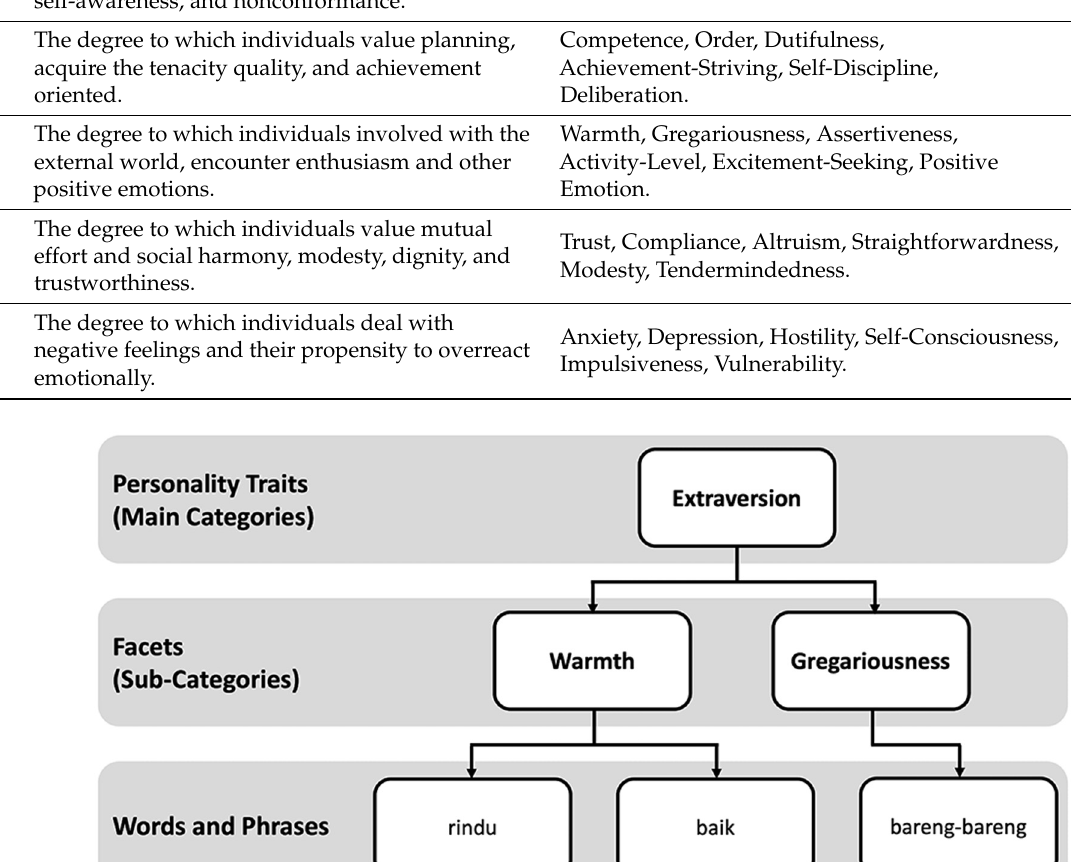
Table 1. Big Five Personality Traits.